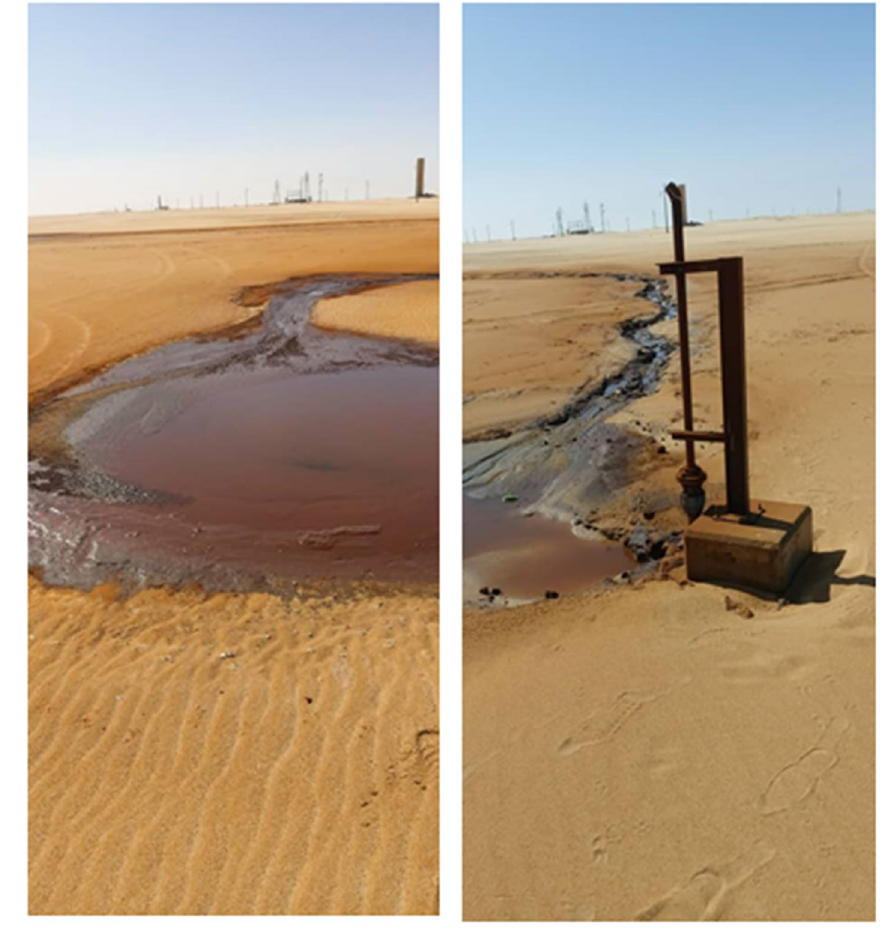
Fig.12 Iron and manganese sludge at Tazerbo